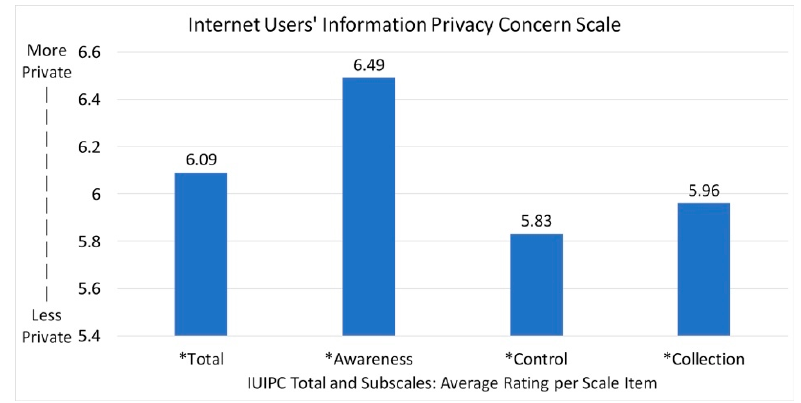
Figure 3. Internet Users’ Information Privacy Concerns (IUIPC) Results.